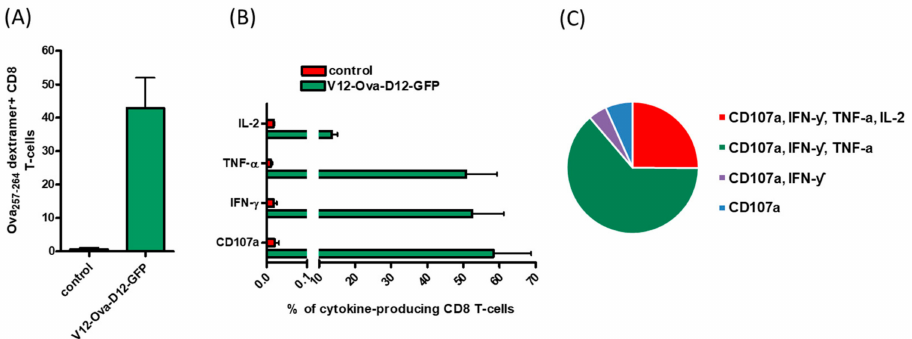
Figure 1. Transgene-specific CD8 + T cell response induced by the ORFV vector. H-2K b C57BL / 6 mice ( n = 6) were immunized i.m. two times with V12-Ova-D12-GFP or negative control V-D12-mCherry. Ova-specific CD8 + T cell response in individual mice was determined one week after the second administration. ( A ) Frequency of specific cytotoxic T lymphocytes of the total CD8 + T cells in the spleen was assessed by Ova 257-264 dextramer staining. ( B ) Percentage of Ova 257-264 SIINFEKL peptide-specific CD8 + T cells producing the indicated cytokines was determined by intracellular cytokine staining. ( C ) Pie chart shows the extent of simultaneous CD107a, TNF- α , IFN- γ and IL-2 production by